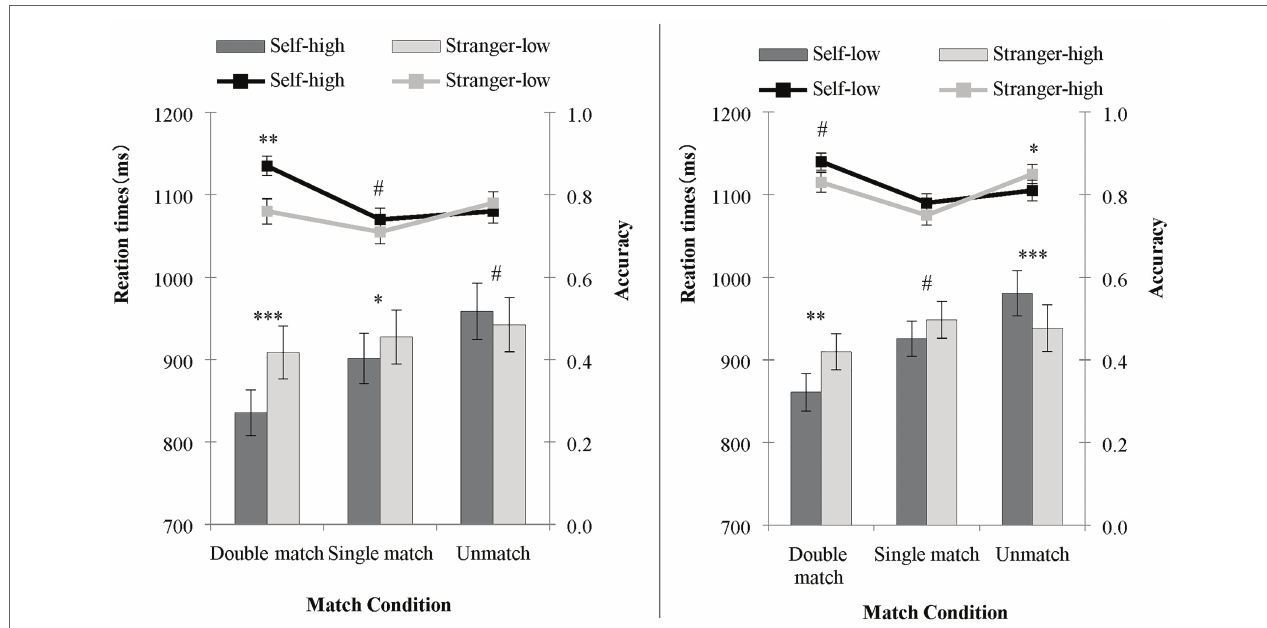
FIGURE 2 | The accuracy and reaction time of judgments under the double salience condition (left) and single salience condition (right) in Experiment 1. The line represents accuracy, and the bars represent the RT. ∗∗∗ p < 0.001; ∗∗ p < 0.01; ∗ p < 0.05; # p =